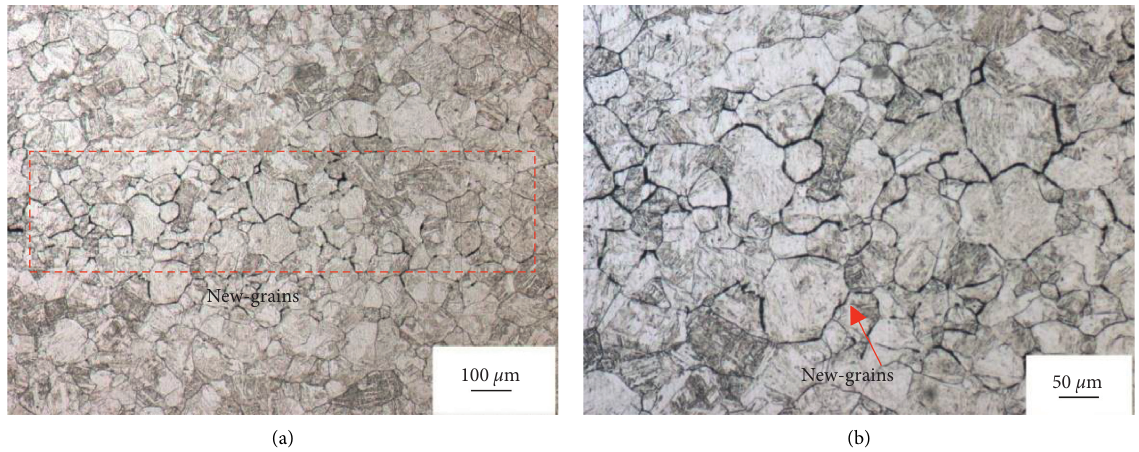
Figure 7: Microstructure of the crack healing zone at FR 2.0. (a) 100 times magnification. (b) 200 times magnification.